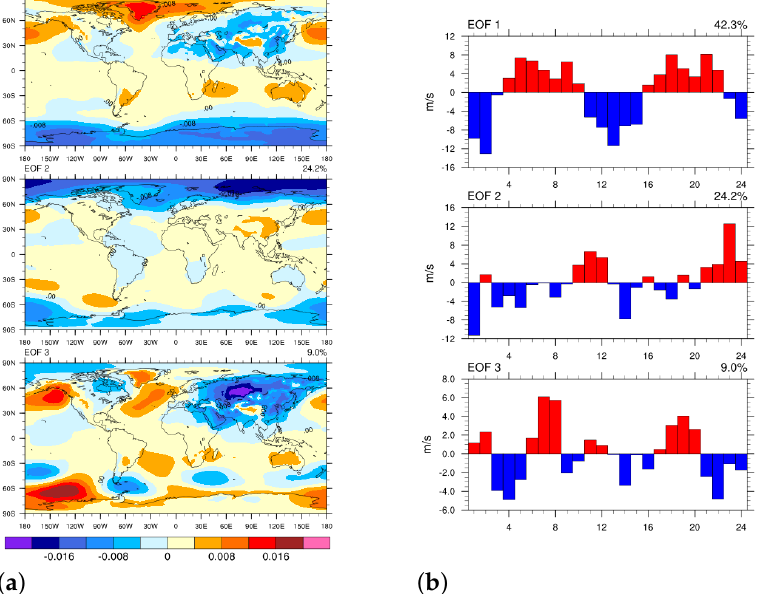
Figure 3. The spatial distribution ( a ) and the time coefficients ( b ) of the first three modes of the MEOF analysis of